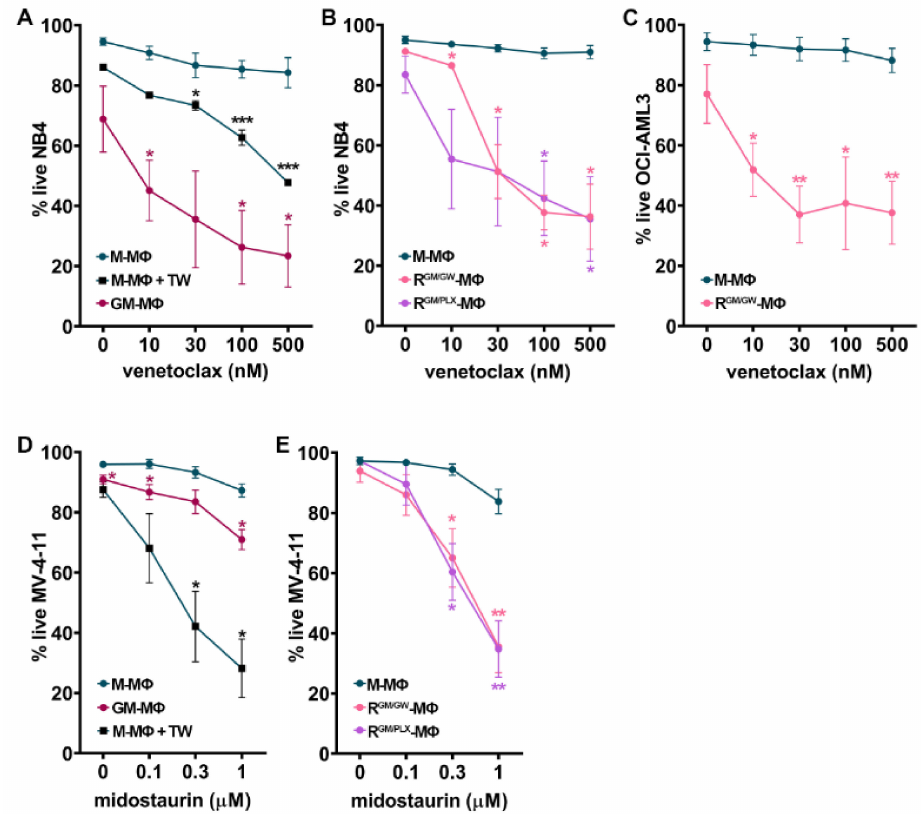
Figure 5. M Φ reprogramming reverses myeloblast resistance to targeted therapy. AML cell lines were cultured with indicated M Φ monolayers for 48 h, and the frequency of live (AnnV/7-AAD-negative) cells was measured by FC in the presence of escalating doses of venetoclax ( A – C ), or midostaurin ( D – E ). ( A ) Frequency of live NB4 cells after culture with GM- or M-M Φ s either in direct contact or separated by a TW. ( B ) Frequency of live NB4 cells cultured with M Φ whose culture medium has been supplemented with M-CSF for 2 weeks (M-M Φ s) or switched to reorienting medium supplemented with GM-CSF (GM) and GW2580 (GW) or PLX3397 (PLX) (R GM/GW - or R GM/PLX -M Φ s) during week#2. ( C ) Frequency of live OCI-AML3 as above ( B ) cultured with M- or R GM/GW -M Φ s. ( D ) Frequency of live (7AAD-negative) MV-4-11 cells after culture with GM- or M-M Φ s either in direct contact or separated by a TW. ( E ) The % of live MV-4-11 cells cultured with M Φ s whose culture medium has been supplemented with M-CSF for 2 weeks (M-M Φ s) or switched to reorienting medium (R GM/GW - or R GM/PLX -M Φ s). Experiments were performed using monocytes isolated from 3–13 different HD. Data points represent the mean ± SEM; * p < 0.05, ** p < 0.01, and *** p < 0.001 to M-M Φ s (M-W